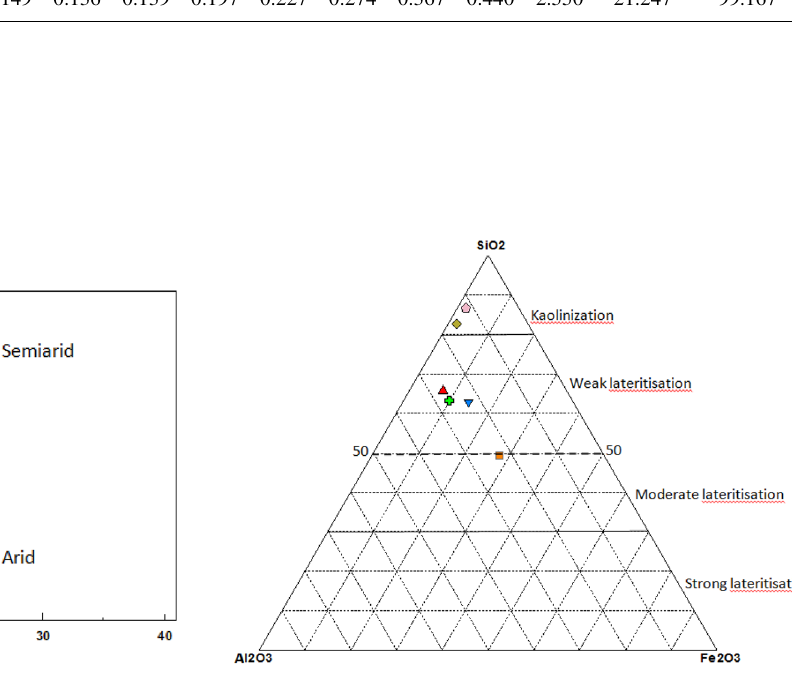
Fig. 10 Paleoclimatic diagram of SiO 2 versus Al 2 O 3 ? K 2 O ? Na 2- O (AFTER Suttner and Dutta 1986)